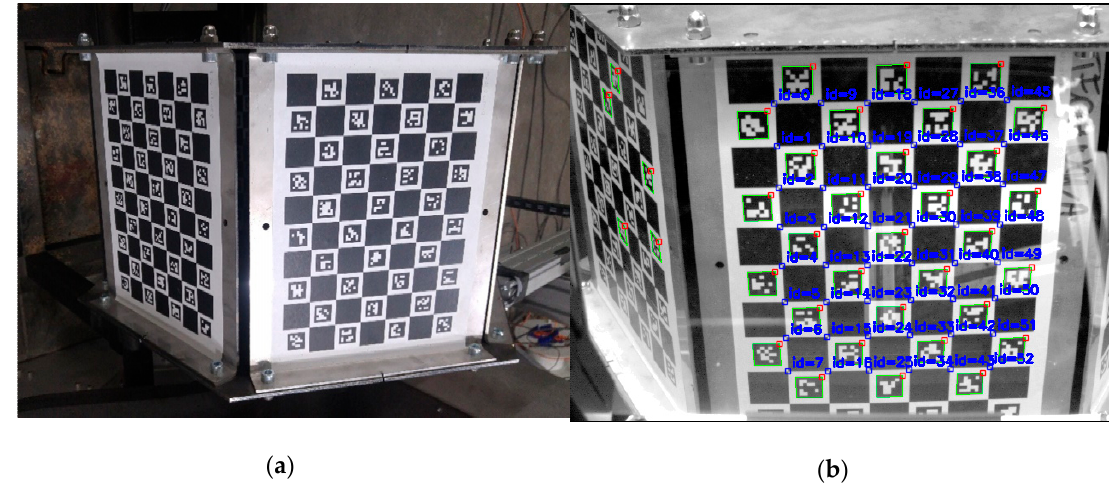
Figure 10. Hexagonal calibration artifact: ( a ) sample view; ( b ) detected markers on the artifact seen by the camera despite the reflections. Correctly detected markers are surrounded in green and calibration points (detected chessboard corners) are marked as blue squares.